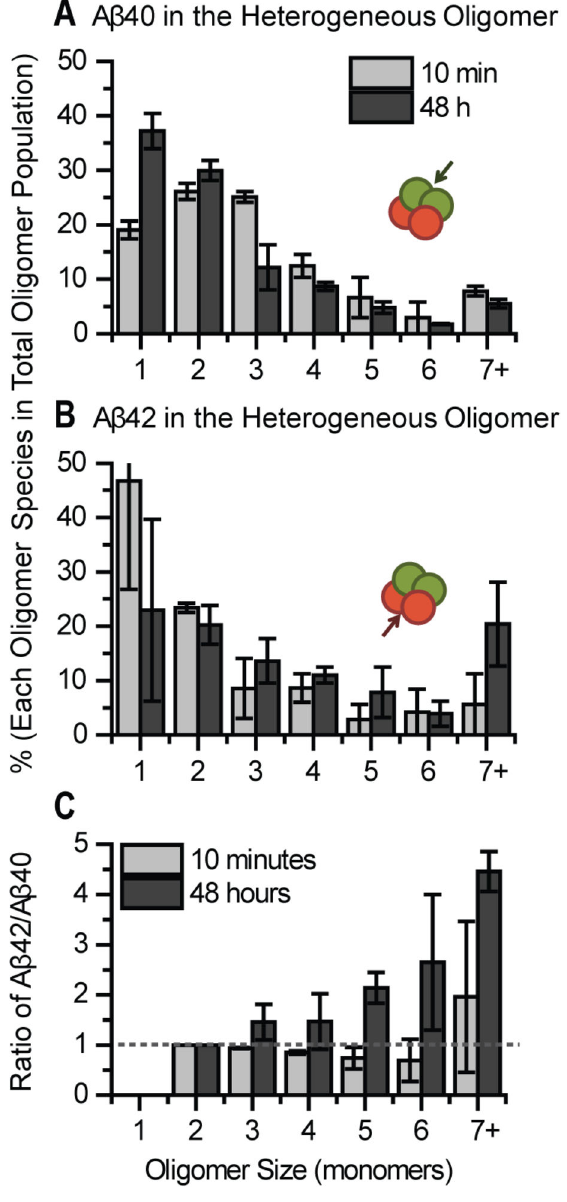
Figure 7. Aβ42 fraction in the heterogeneous oligomers increases dramatically over time but not Aβ40. (A) The size of Aβ40 in the heterogeneous species (as indicated by the green arrow) shifts to smaller species after 48 hours (Mann- Whitney U test, p = 8.6E-7). (B) The size of Aβ42 in the heterogeneous species (as indicated by the red arrow) increases considerably up to 48 hours (Mann-Whitney U test, p = 6.3E-7). (C) The ratio was calculated by dividing the number of Aβ42 monomer by the number of Aβ40 monomer in each individual heterogeneous species. The dashed line indicates ratio 1 at which value the amount of Aβ42 is equal to Aβ40. Data was calculated from two different experiments, at least 5 images each. Each image contained at least 50 oligomers. Error bars represent standard deviation of the mean. doi: